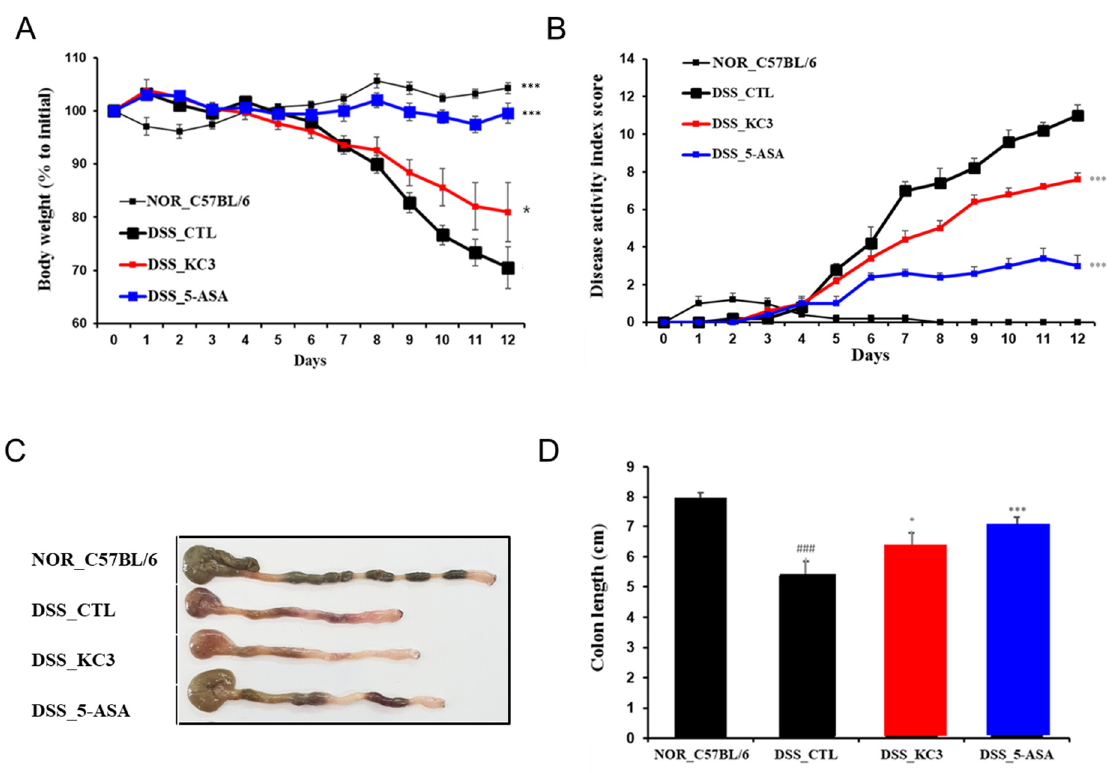
Figure 3. Protective effect of KC3 on DSS-induced colitis. The clinical assessment of the DSS-induced colitis model in mice was conducted through daily measurements of body weight ( A ) and disease activity score ( B ). A representative image of the colon is shown in ( C ), and the total length from the anus to the cecum was measured on the fourth day after DSS cessation ( D ). 5-ASA, 5-aminosalicylic acid. *, *** Significant difference compared with the DSS control group ( p < 0.05, p < 0.01). ### Significant difference compared with the normal group ( p < 0.01). Data are represented as mean ± SD ( n = 6 per group).